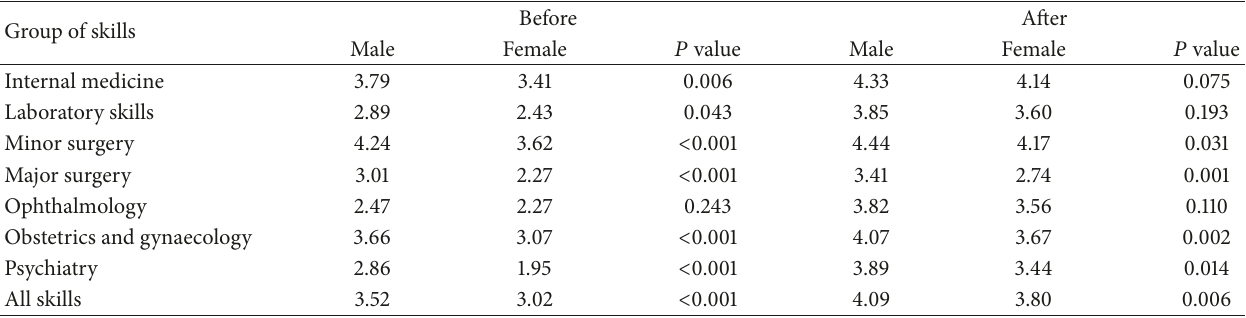
Table 4: Gender variation in self-assessed competences in discipline-based groups of skills among master’s programme’s candidates at the GFMP, Gezira state, Sudan ( 𝑁 = 108 , 46 males and 62 females). Before After Group of skills Male Female 𝑃 value Male Female